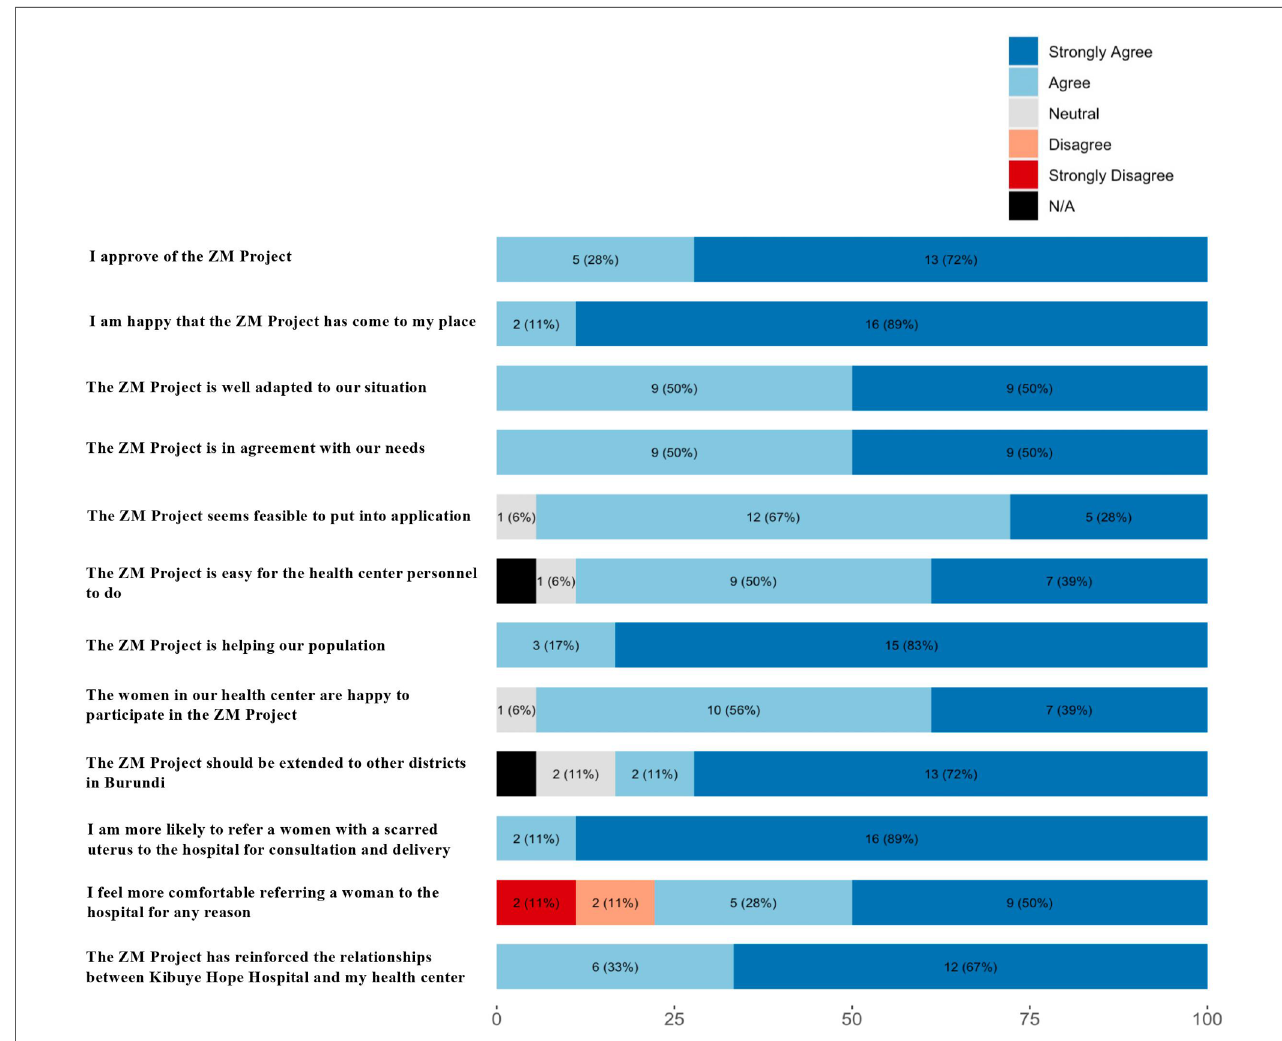
FIGURE 2 Results of feedback from personnel of the 18 health centers in kibuye health district regarding the zigama mama project., n (%). Each of the twelve questions were asked and evaluated by a representative of each of the 18 health centers on a 5 point Likert scale (strongly disagree to strongly agree). Data are presented as frequency and percentage of response to each